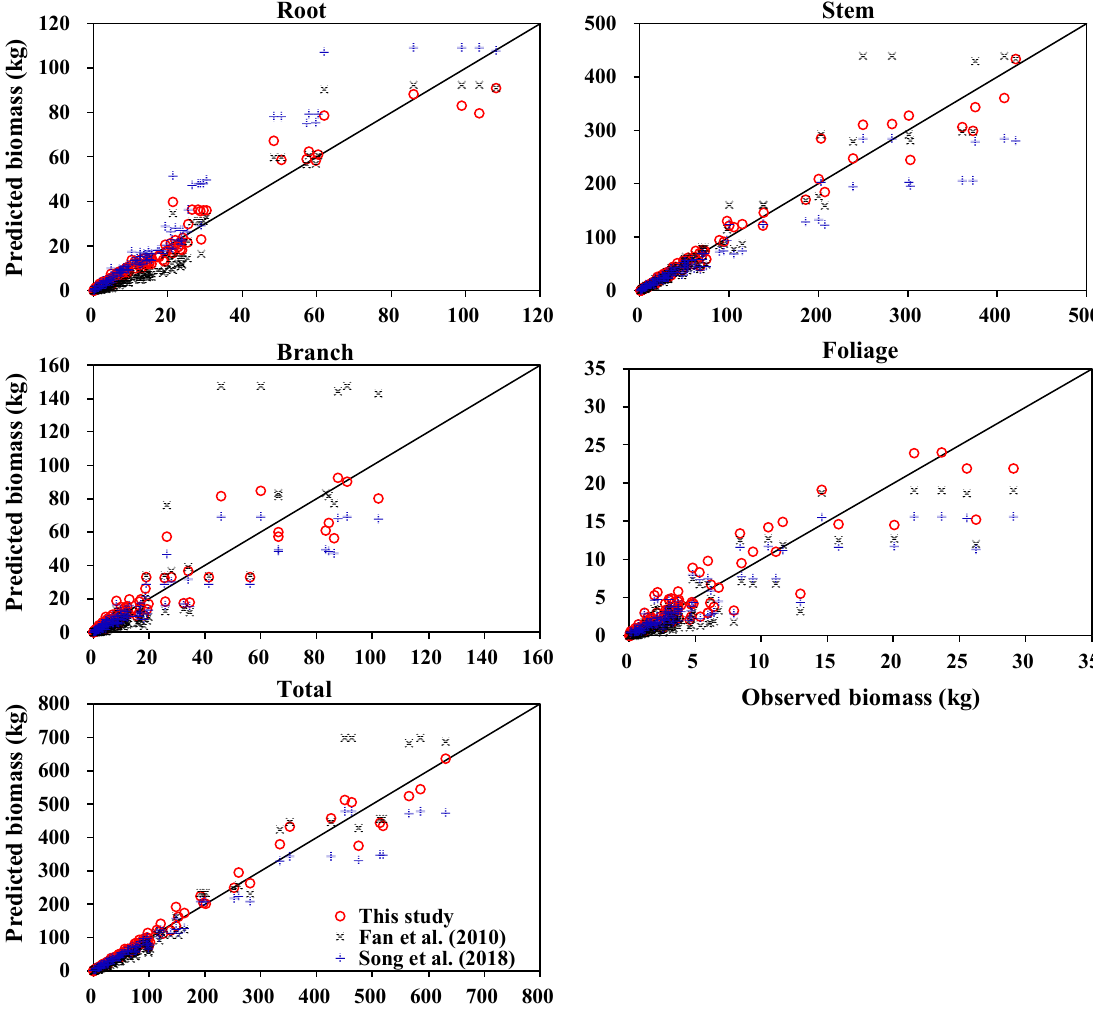
Figure 6. The predictions of each component and total biomass from this study (MS2) compared to biomass equations based on D and combination of D and H developed by Fan et al. [41] and Song et al. [42], respectively.